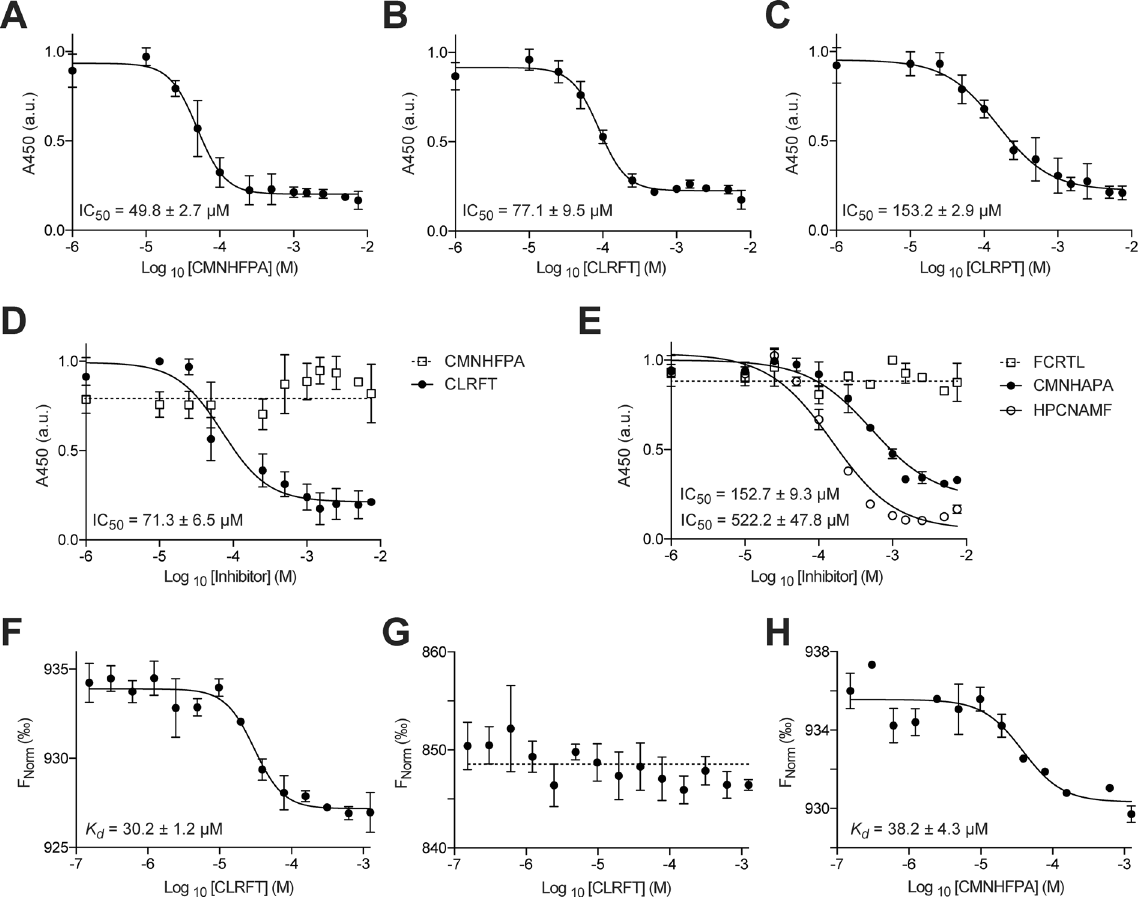
Figure 2. In vitro analysis of the selected PA/CMG2 inhibitors by ELISA and MST. ( A ) CMNHFPA disrupts the interaction of His